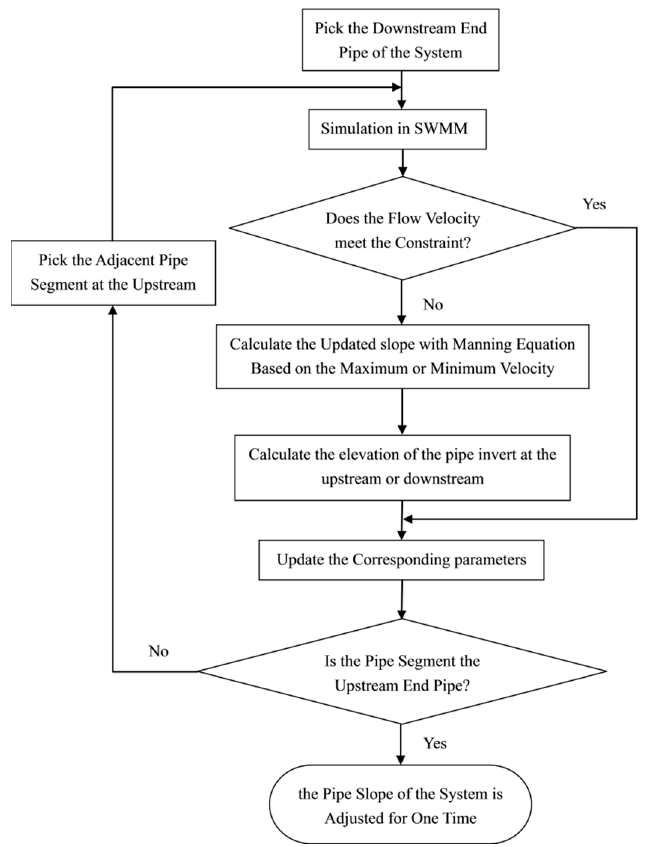
Figure 4. Flowchart for the design process in the second stage.